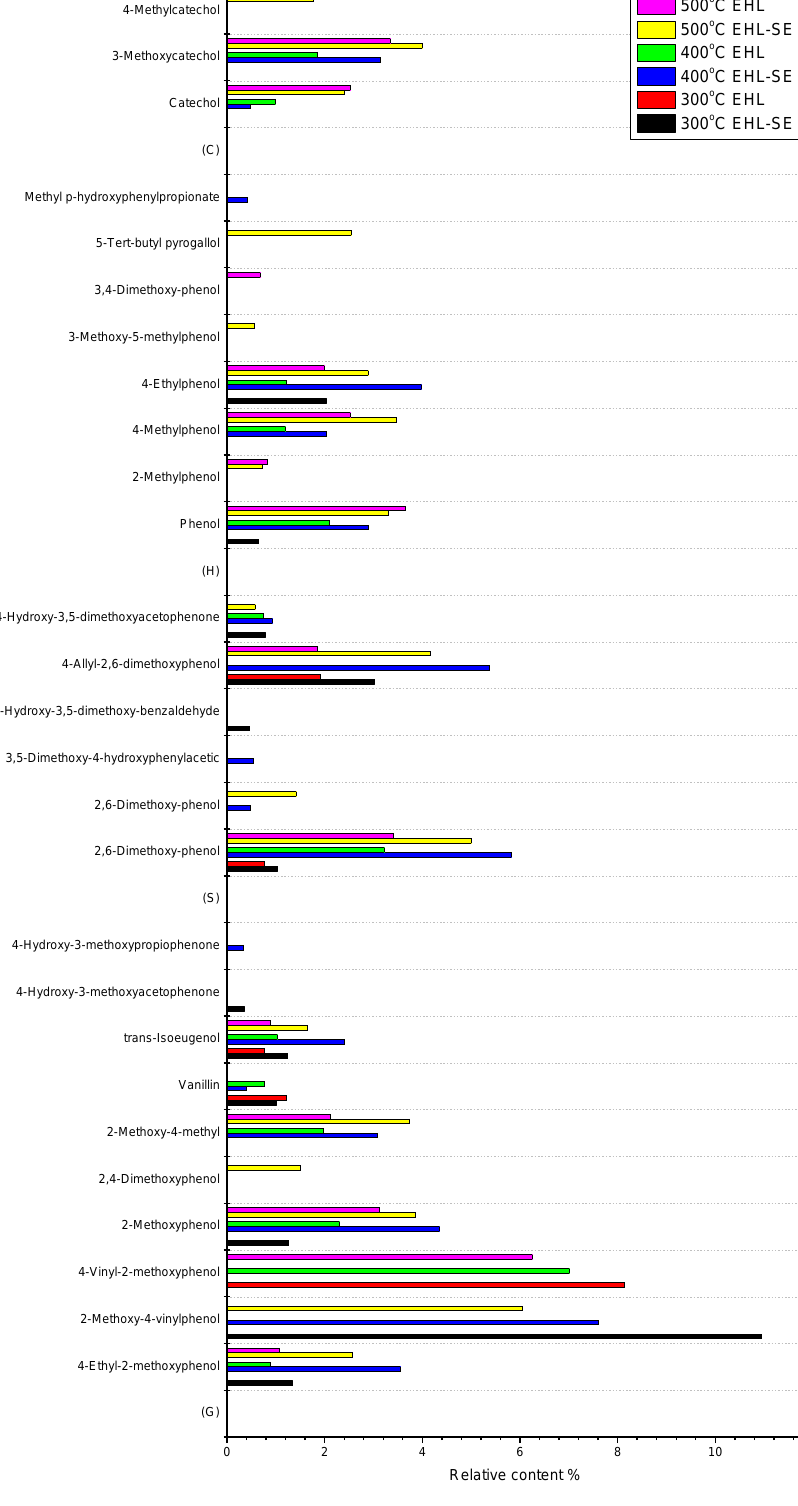
Figure 5. Total product distribution of phenolic compounds obtained by pyrolysis of EHL and EHL-SE with different temperatures.